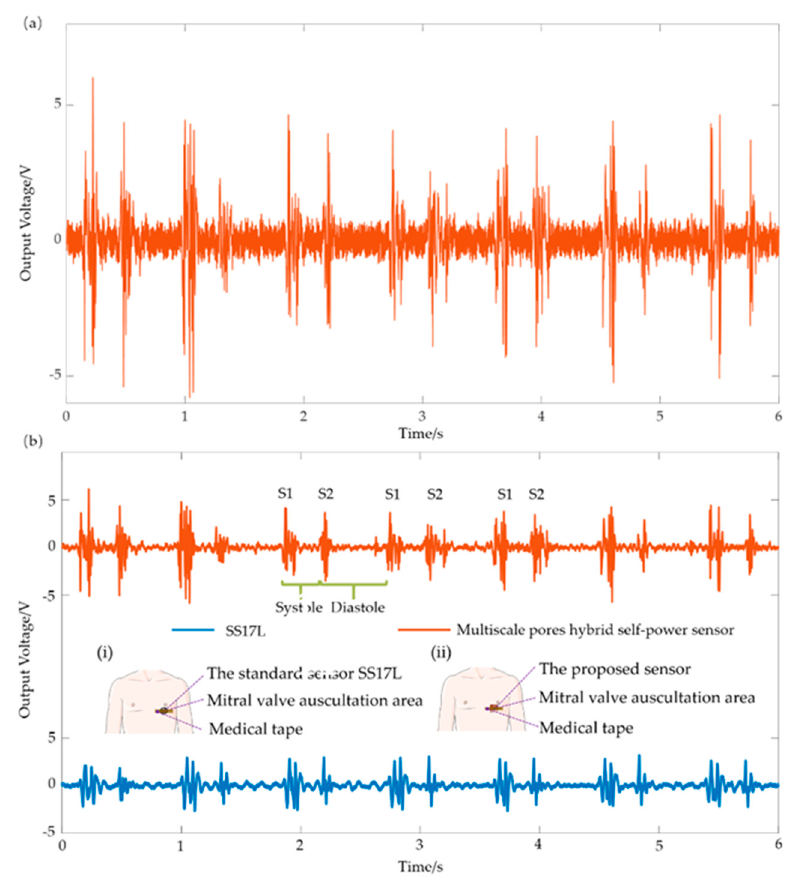
Figure 10. Schematic of heart sound detection in the human body. ( a ) Original signal of the heart sound signal; ( b ) heart sound signals after treatment with a filter. ( i ) Schematic drawing of the attachment of the standard sensor SS17L (BIOPAC, Goleta, CA, USA); ( ii ) schematic drawing of the attachment of the proposed flexible sensor.